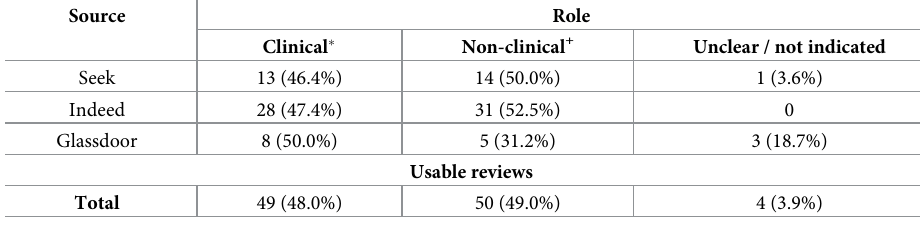
Table 5. Role type indicated by reviewers across sites.